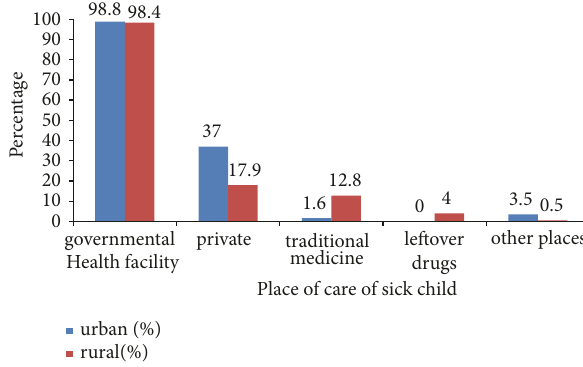
Figure 3: Place of care for sick child among caregivers of under-five children in urban and rural resident of Doba woreda,